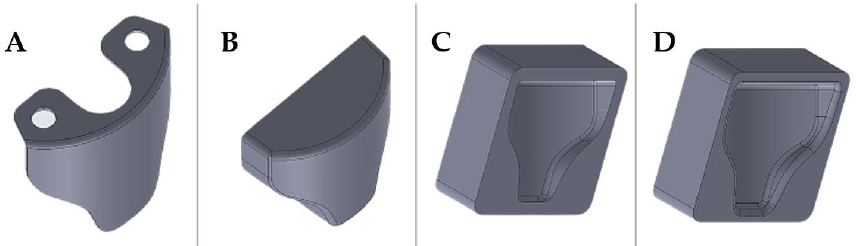
Figure 2. Steps followed during the design of the mold cad model, starting from: ( A ) the actual part, ( B ) making the solid block, ( C ) Cavity extrusion on Mold part, ( D ) Surface-optimized Mold .